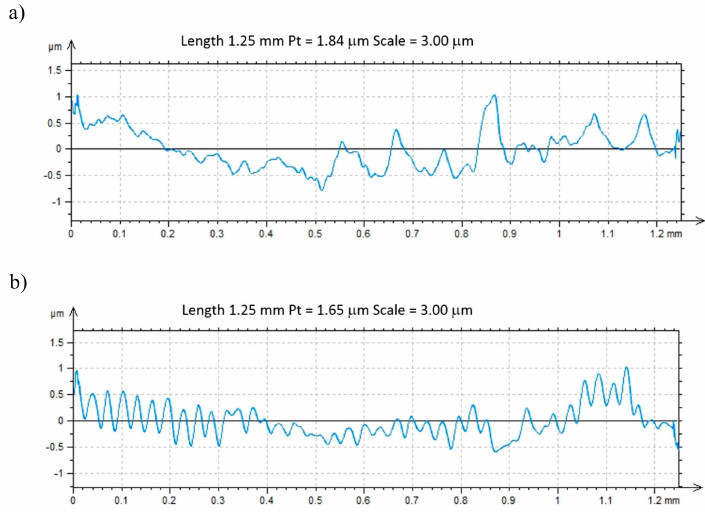
Figure 9. Cross section profiles of cemented carbides wear during pin on disc test: ( a ) before laser texturing, ( b ) after laser